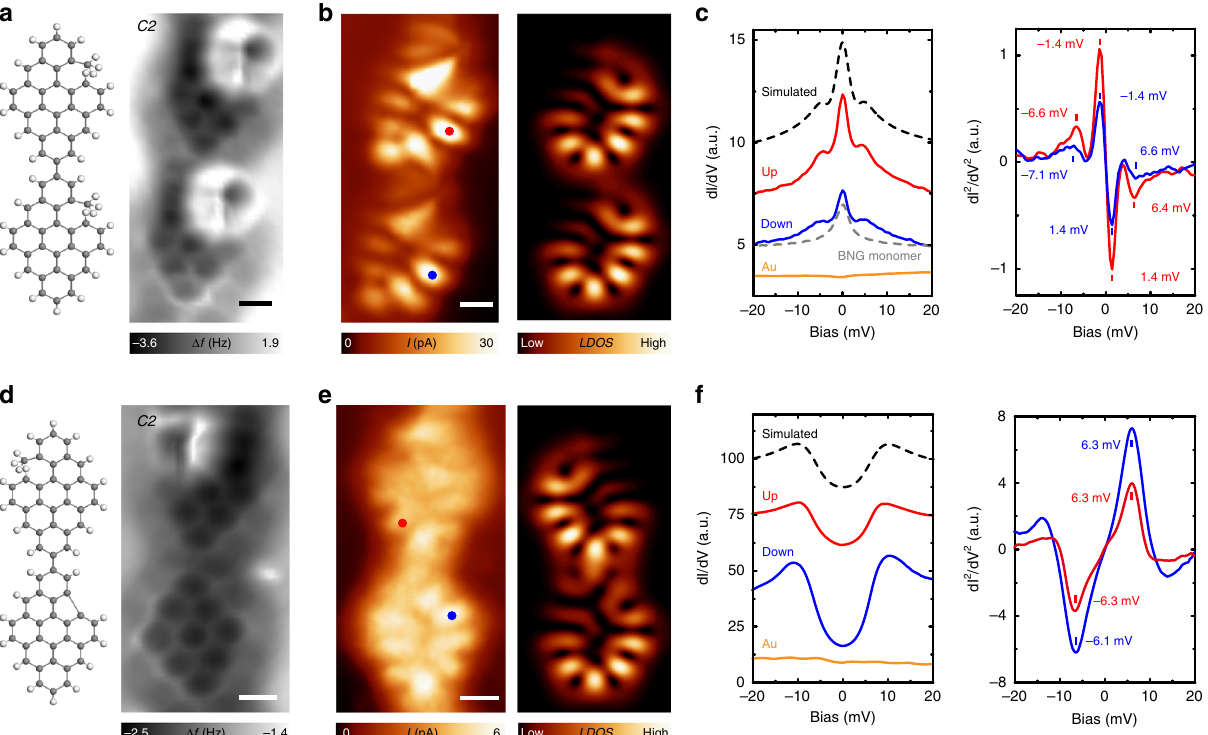
Fig. 3 Determining the spin order in diradical nanographene dimers by spin- fl ip spectroscopy. a Chemical structure and nc-AFM image (Resonant frequency: 29 KHz, Oscillation amplitude: 160 pm) of a BNG – BNG dimer. b Constant-height current image (Bias voltage: 1 mV) and simulated LDOS map of the dimer in a . c d I /d V spectra (modulation: 0.1 mV, Temperature: 1.1 K) and numerical calculated d I 2 /d V 2 spectra taken on the two locations marked in b . Three resonances have been detected, suggesting a ferromagnetic coupled ground state with S = 1. The black dashed line is simulated line shape using a perturbative approach up to third order. d Chemical structure and nc-AFM image (Resonant frequency: 22 KHz, Oscillation amplitude: 140 pm) of a BNG – nBNG hetero-dimer. e Constant-height current image (Bias voltage: 1 mV) and simulated LDOS map of the dimer in d . f d I /d V spectra and numerical calculated d I 2 /d V 2 spectra taken on the two locations marked in e . Two symmetric peaks have been detected, suggesting an antiferromagnetic coupled ground state with S = 0. The black dashed line is simulated line shape using a perturbative approach up to third order. Scale bars: 0.3